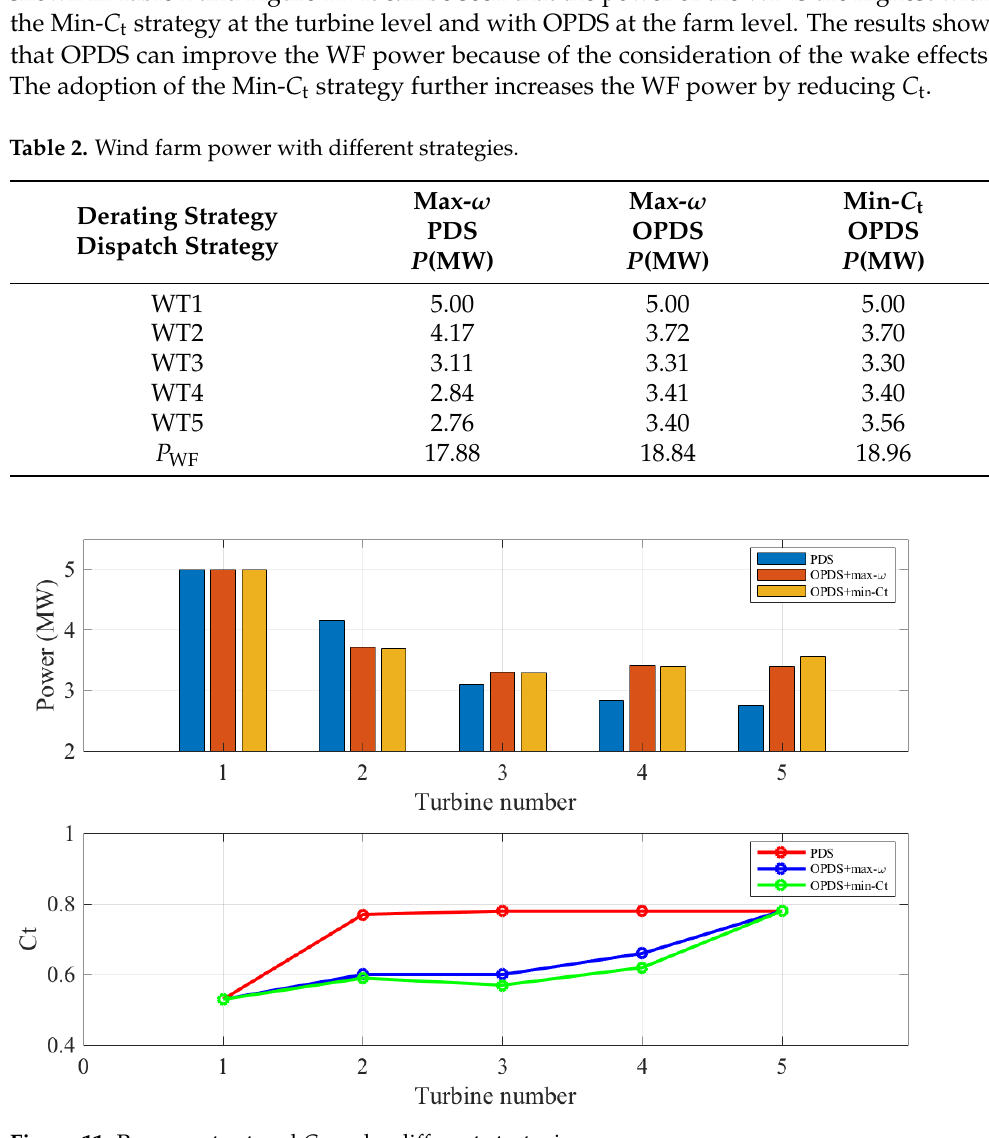
Figure 11. Power output and C t under different